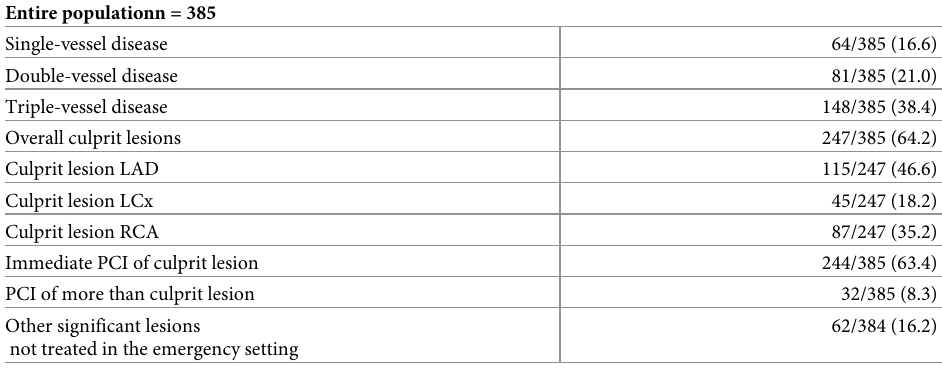
Table 5. Coronary angiographic and intervention findings in patients with immediate CAG.